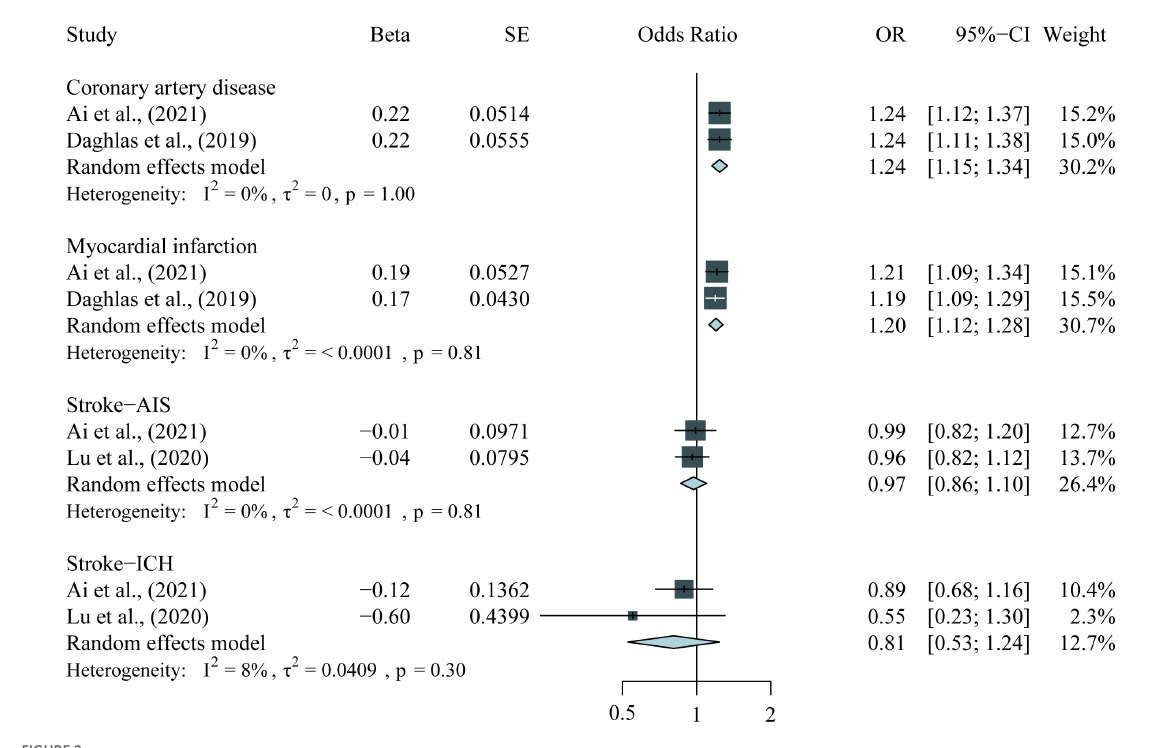
FIGURE2 Meta-analysis results for the association between short sleep duration and CVDs in MR studies. CVDs, cardiovascular diseases; MR, Mendelian randomization; AIS, any ischemic stroke; ICH, primary intracranial hemorrhage.